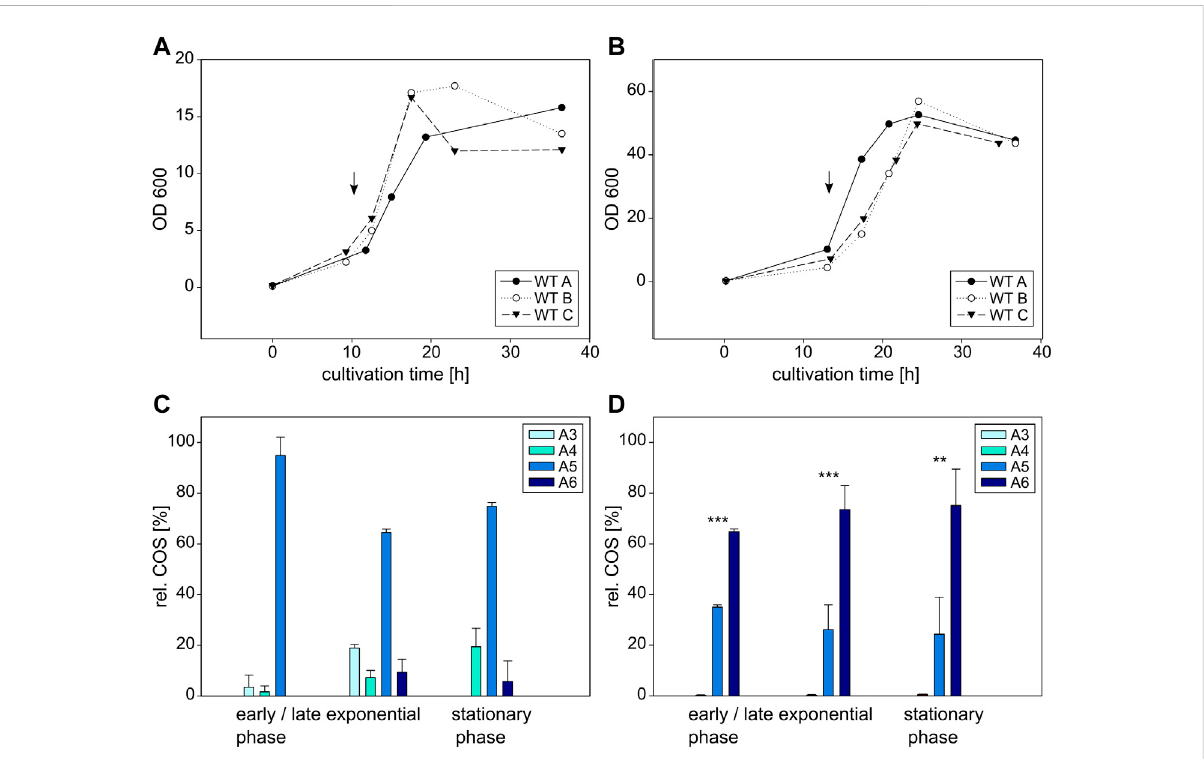
FIGURE 5 Cultivation and COS production of E coli BL21 (left) and C glutamicum (right) expressing the wildtype NodC_GRH2. Depicted is the growth of E. coli (A) and C. glutamicum (B) in triplicates as well as their product composition (C,D) . The time of induction is denoted with an arrow. MS signals were converted into molar fractions and are shown as shares of the total amount of product, namely the relative amount of fully acetylated trimer (A3) to hexamer (A6) for E. coli (C) and C. glutamicum (D) . The asterisks in D indicate the signi fi cance level for the difference between the product compositions in the same cultivation phase between E. coli (C) and C. glutamicum (D) determined with an independent samples t